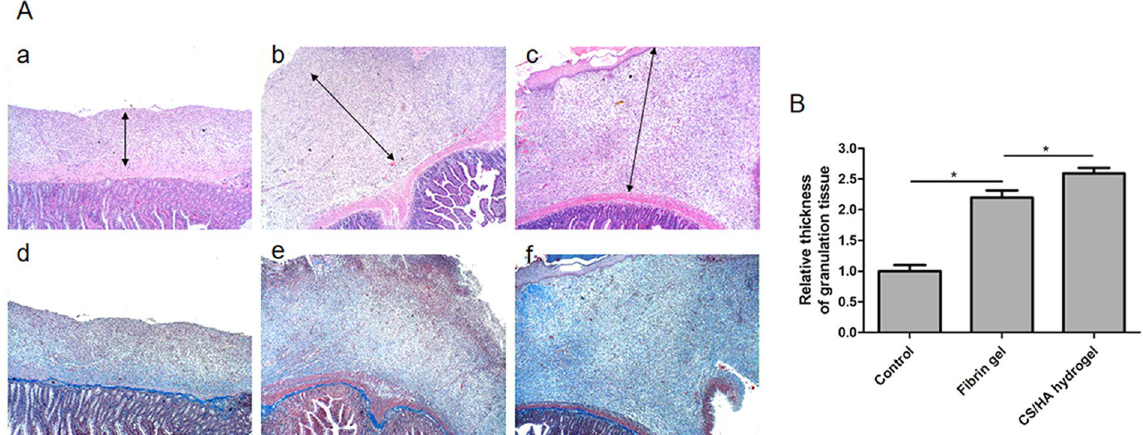
Figure 3. ( A ) Representative H&E and Masson’s trichrome stained histologic cross sections of different groups: the Control (a and d), Fibrin gel (b and e), and CS/HA hydrogel (c and f). Staining for the upper image is with H&E, and for the lower image with Masson’s trichrome. ( B ) The statistical analysis of the relative connective tissue thickness in the three groups. Data are presented as mean with standard deviation as error bars, * P < 0.05.